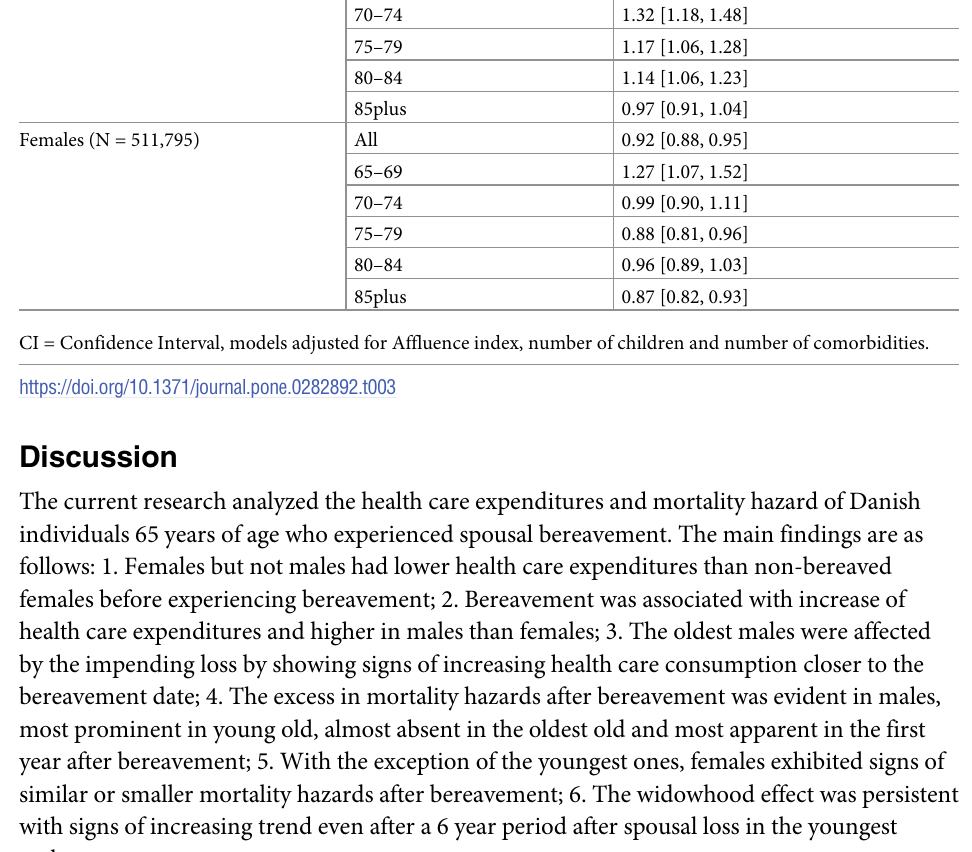
Table 3. Sex and age stratified hazard ratios (95% CI) for all-cause mortality of individuals who suffer bereave- ment in the first year after spousal loss compared to those who did not.